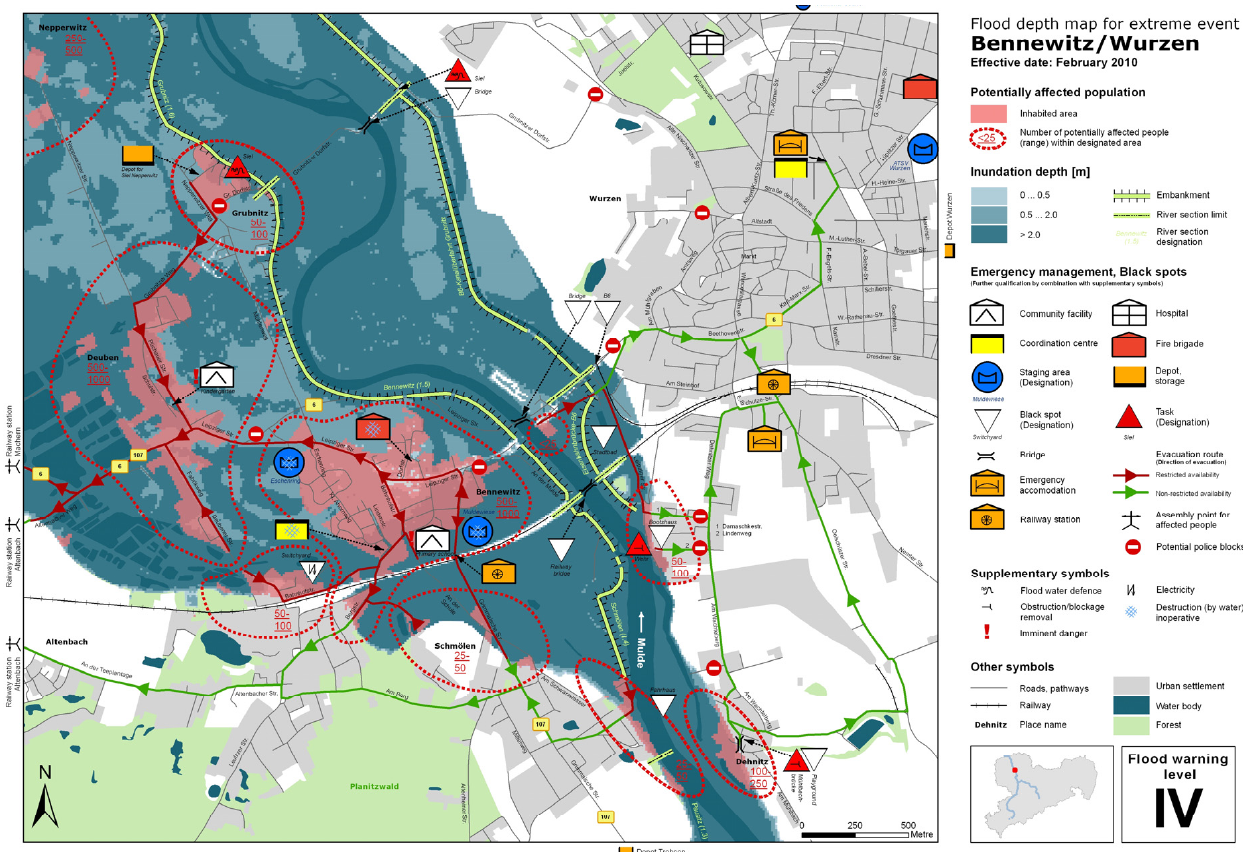
Figure 2: Example for a map for emergency management (case study Saxony): Map contents include inundation depth and affected population, but also important emergency management information (coordination centre, assembly points, evacuation routes) and critical infrastructure. Map contents and visualisation have been updated (compared to Figure 1) based on the results of the eye-tracking tests and the second stakeholder workshop. 720